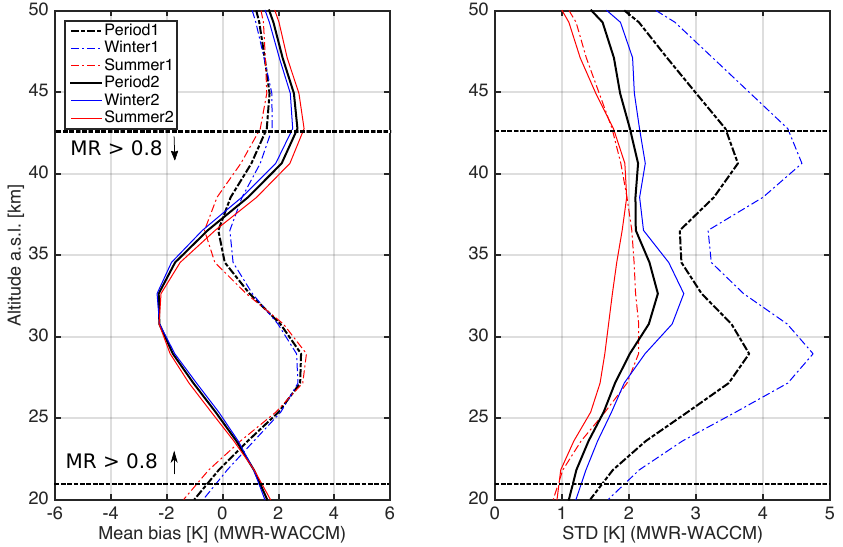
Figure 16. Mean temperature deviation between TEMPERA and the WACCM model. A total of 6868 profiles have been compared (Period 1: 4339 profiles, dashed lines; Period 2: 2529 profiles, solid lines). The mean and the standard deviations for each period are represented by black lines. The winter season is indicated by blue lines while the summer is indicated by red lines (Winter1: 2361 profiles; Summer1: 1978 profiles; Winter2: 1473 profiles Summer2: